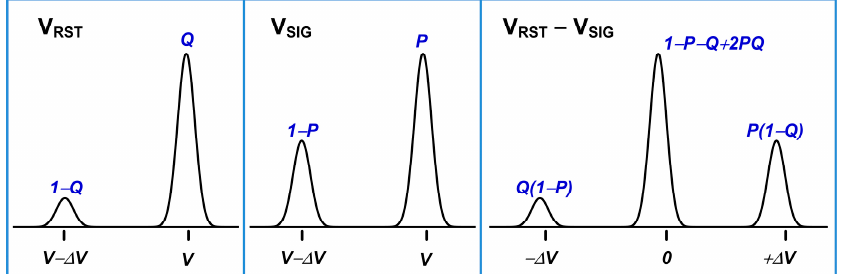
Figure 21. A hypothetical noise distribution before and after CDS. The reset noise V RST is sampled first (the leftmost panel) and the signal voltage V SIG is sampled second (the middle panel). The 2 results are subtracted by CDS operation (the rightmost panel). Assuming that the probability of trap occupancy is Q at the first sampling and P at the second sampling, the probabilities of the 3 peaks after CDS can be calculated as in the rightmost panel. If P = Q the 2 side peaks would be symmetric. If Q ≠ P we would observe 2 asymmetric side peaks. In the case of Q = 0, only 2 peaks are observable.